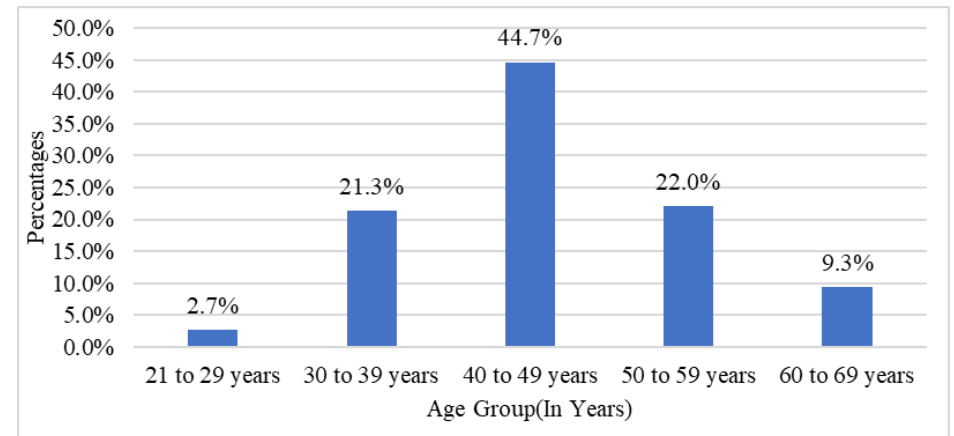
Figure 1. Bar graph of age groups in the study population.